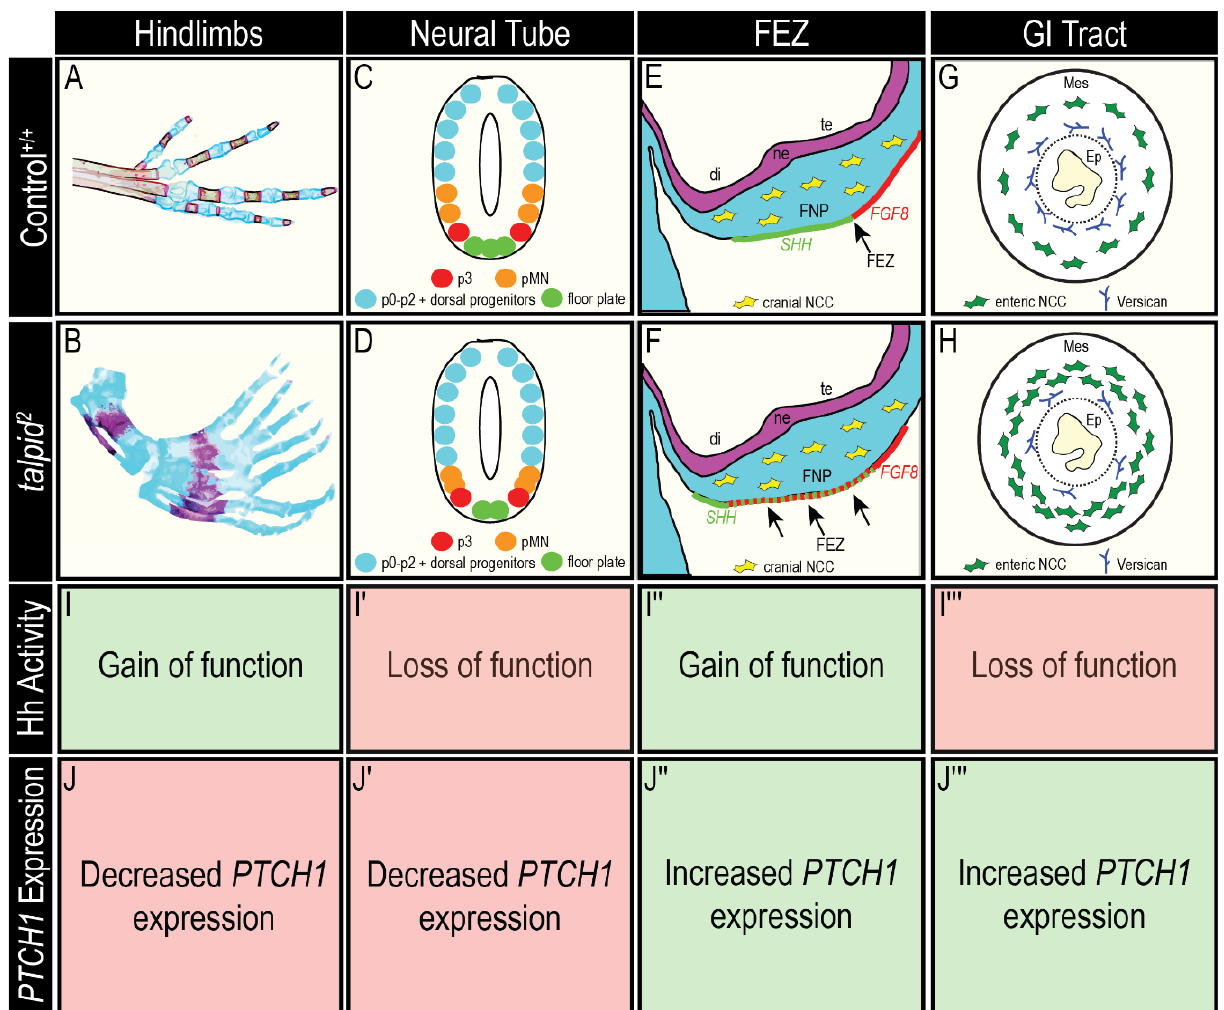
Figure 8. Summary of phenotypes, associated Hh activity, and PTCH1 expression across Hh-dependent signaling centers in control and ta 2 embryos. ( A – H ) Schematics of ( A , B ) hindlimb, ( C , D ) neural tube, ( E , F ) FEZ, and ( G , H ) GI tract phenotypes in ( A , C , E , G ) control +/+ and ( B , D , F , H ) ta 2 embryos. ( I – I ’’’) Level of Hh activity associated with ta 2 phenotypic presentations. ( J – J ’’’) Summary of PTCH1 expression in ta 2 organs. di: diencephalon, Ep: epithelium, FEZ: frontonasal ectodermal zone, FNP: frontonasal prominence, Mes: intestinal mesenchyme, NCC: neural crest cell, ne: neuroepithelium, pMN: motor neuron progenitors, te: telencephalon.